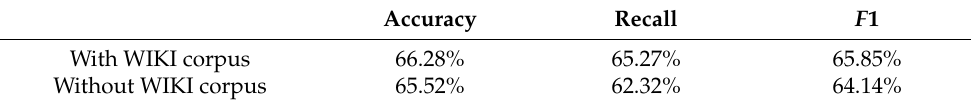
Table 2. WIKI test results.